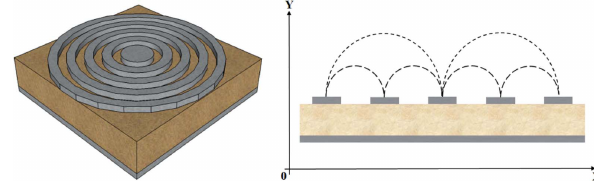
Figure 8. Fringing electric field (FEF) sensor used for spatial imag- ing of the moisture present in the sample under